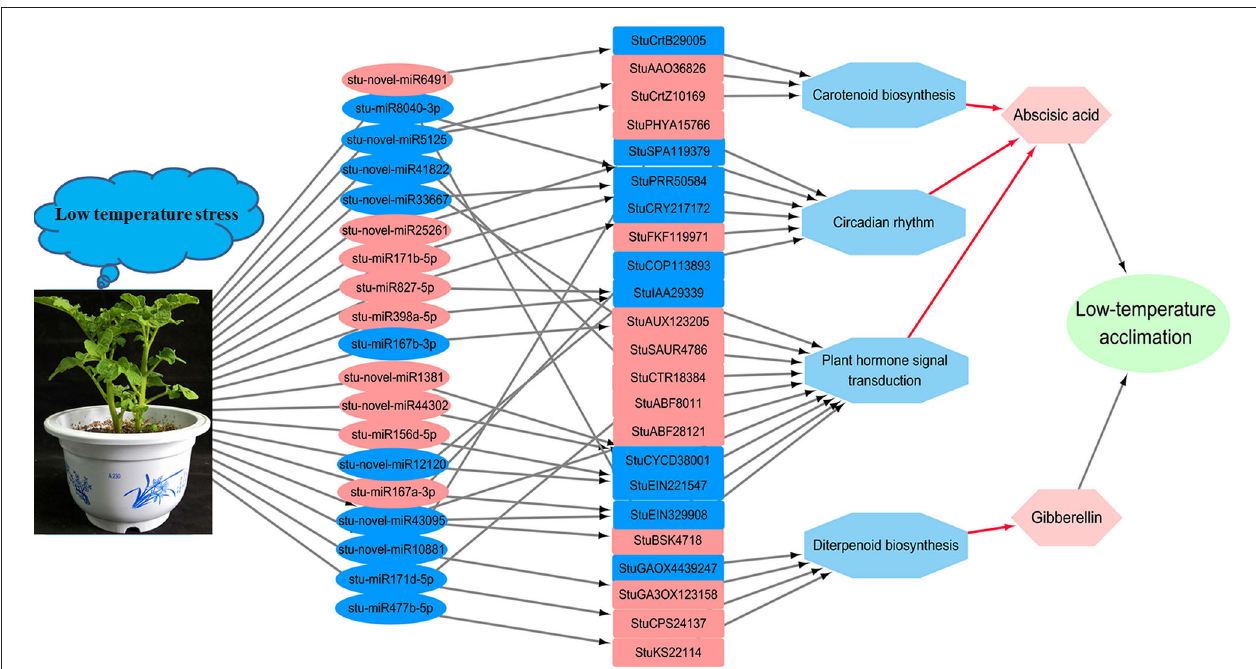
FIGURE 9 | The diversified low-temperature responsive pathways of DE miRNAs targets during low-temperature stress in the potato. The nodes are marked in red background color indicating the miRNAs or genes are up-regulated expression, the nodes are marked in blue background color indicating the miRNAs or genes are down-regulated expression. Under low-temperature stress, the expression of the miRNAs was changed. The up-/ down-regulation of miRNAs result in the down-/ up-regulation of their target genes involved in Carotenoid biosynthesis, Circadian rhythm, Plant hormone signal transduction and Carotenoid biosynthesis, and changing the Abscisic acid and Gibberellin activity, thereby changing the ability of potato to resist low temperature